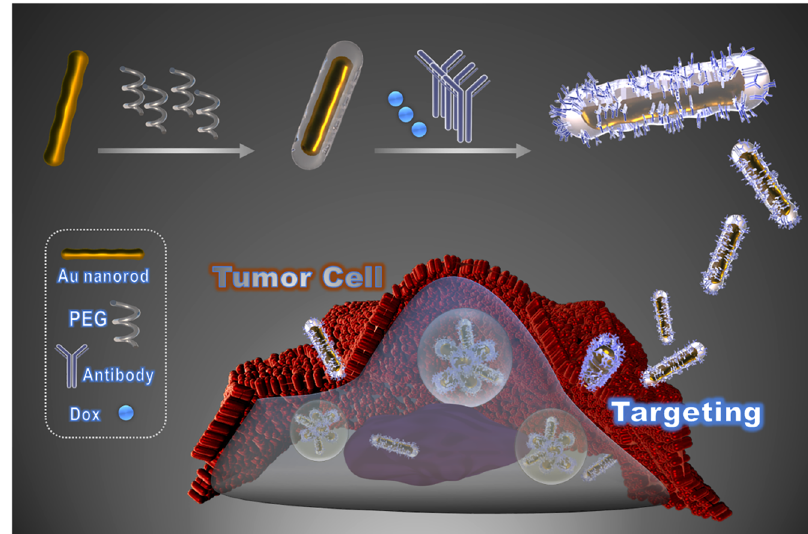
Fig. 1 Scheme. The fabrication and drug delivery of AuNR-PEG-Ab-DOX.